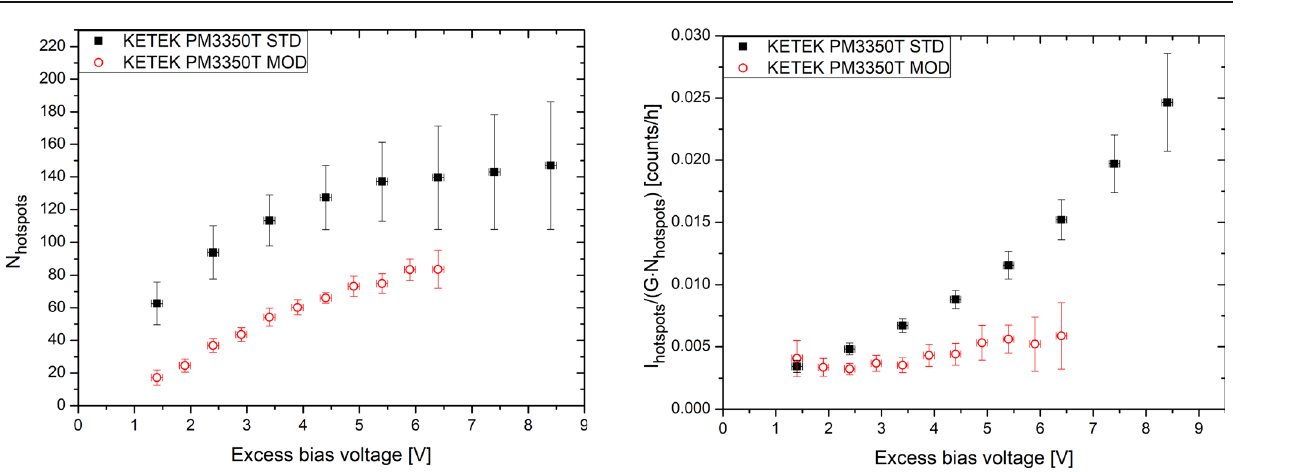
Fig. 14 Number of hotspots as a function of Δ V